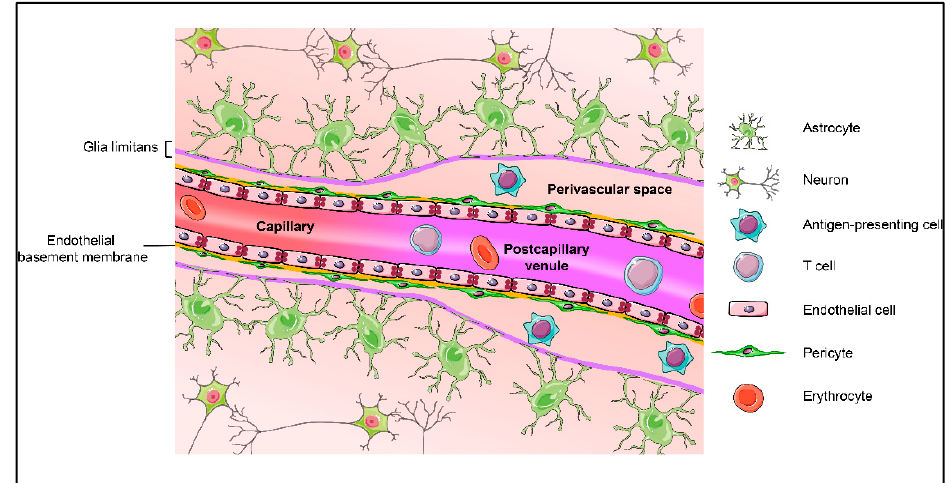
Figure 1. Schematic representation of the components of the neurovascular unit at the level of brain capillaries and post-capillary venules. Drawings of the individual cell types were adapted from Servier Medical Art (http://smart.servier.com/), licensed under a Creative Common Attribution 3.0 Generic